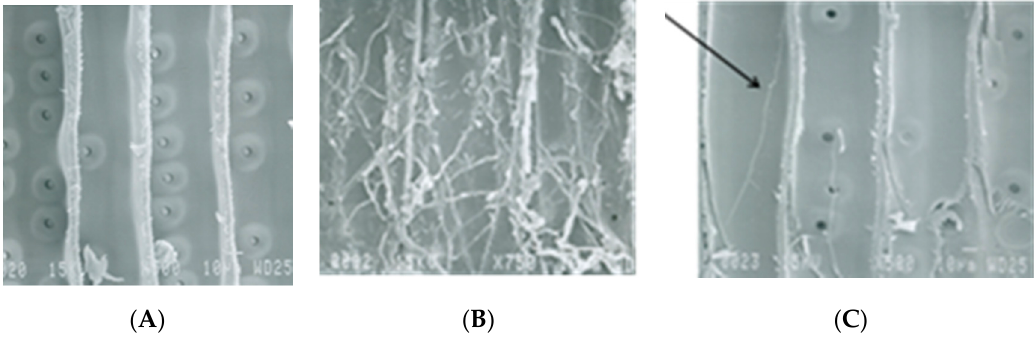
Figure 1. Electron micrographs of pine control before test ( A ), control after 12 weeks with a brown-rot fungus ( C ), and acetylated ( B ) after the 12-week test.